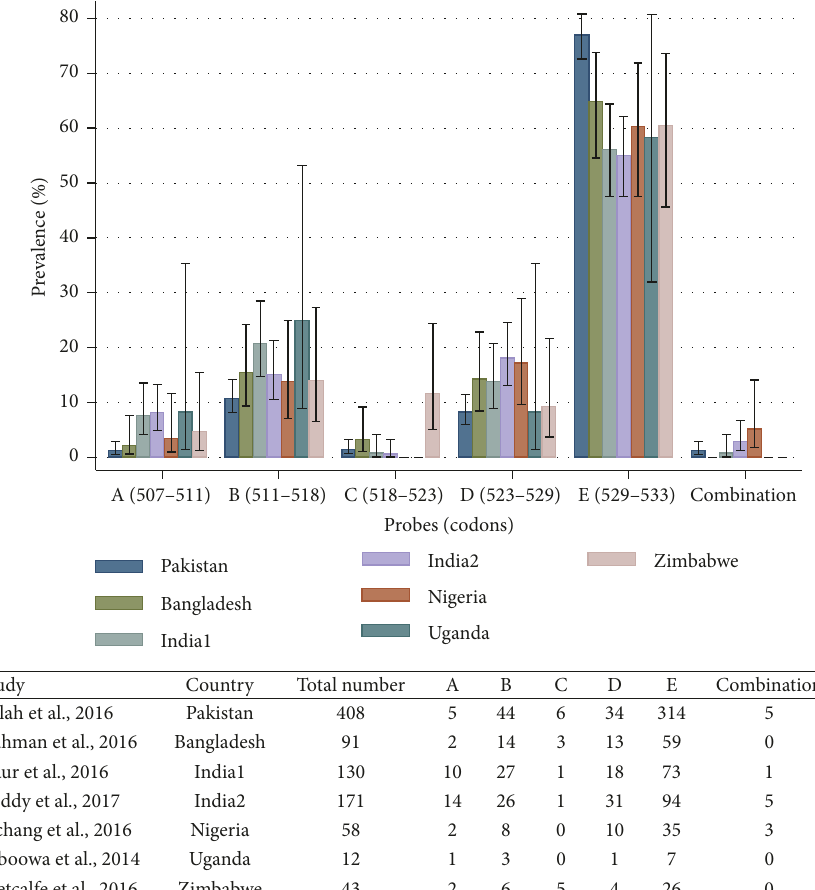
Figure 2: Comparison of the prevalence of probe failures conferring rifampicin resistance using the GeneXpert MTB/RIF assay in seven